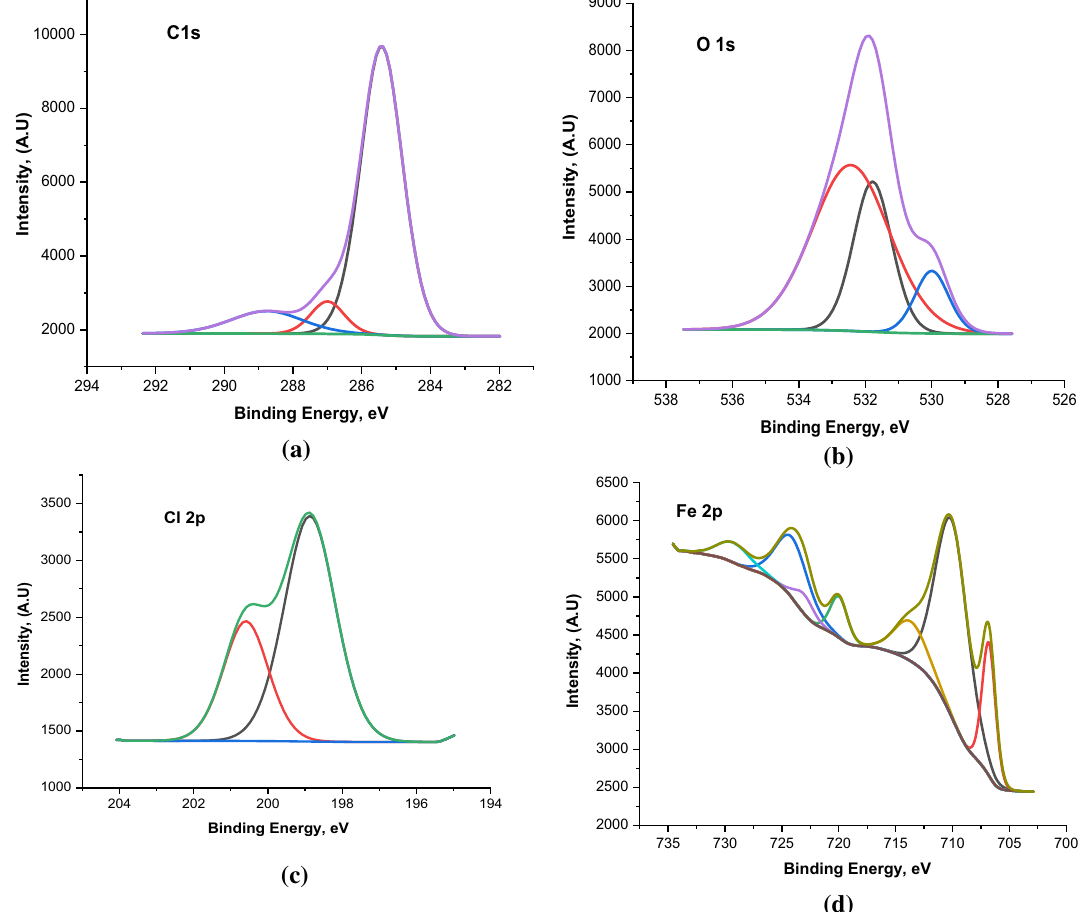
Figure 16. High-resolution X-ray photoelectron deconvoluted profiles of ( a ) C 1 s, ( b ) O 1 s, ( c ) Cl 2p, and ( d ) Fe 2p for carbon steel in 1 M